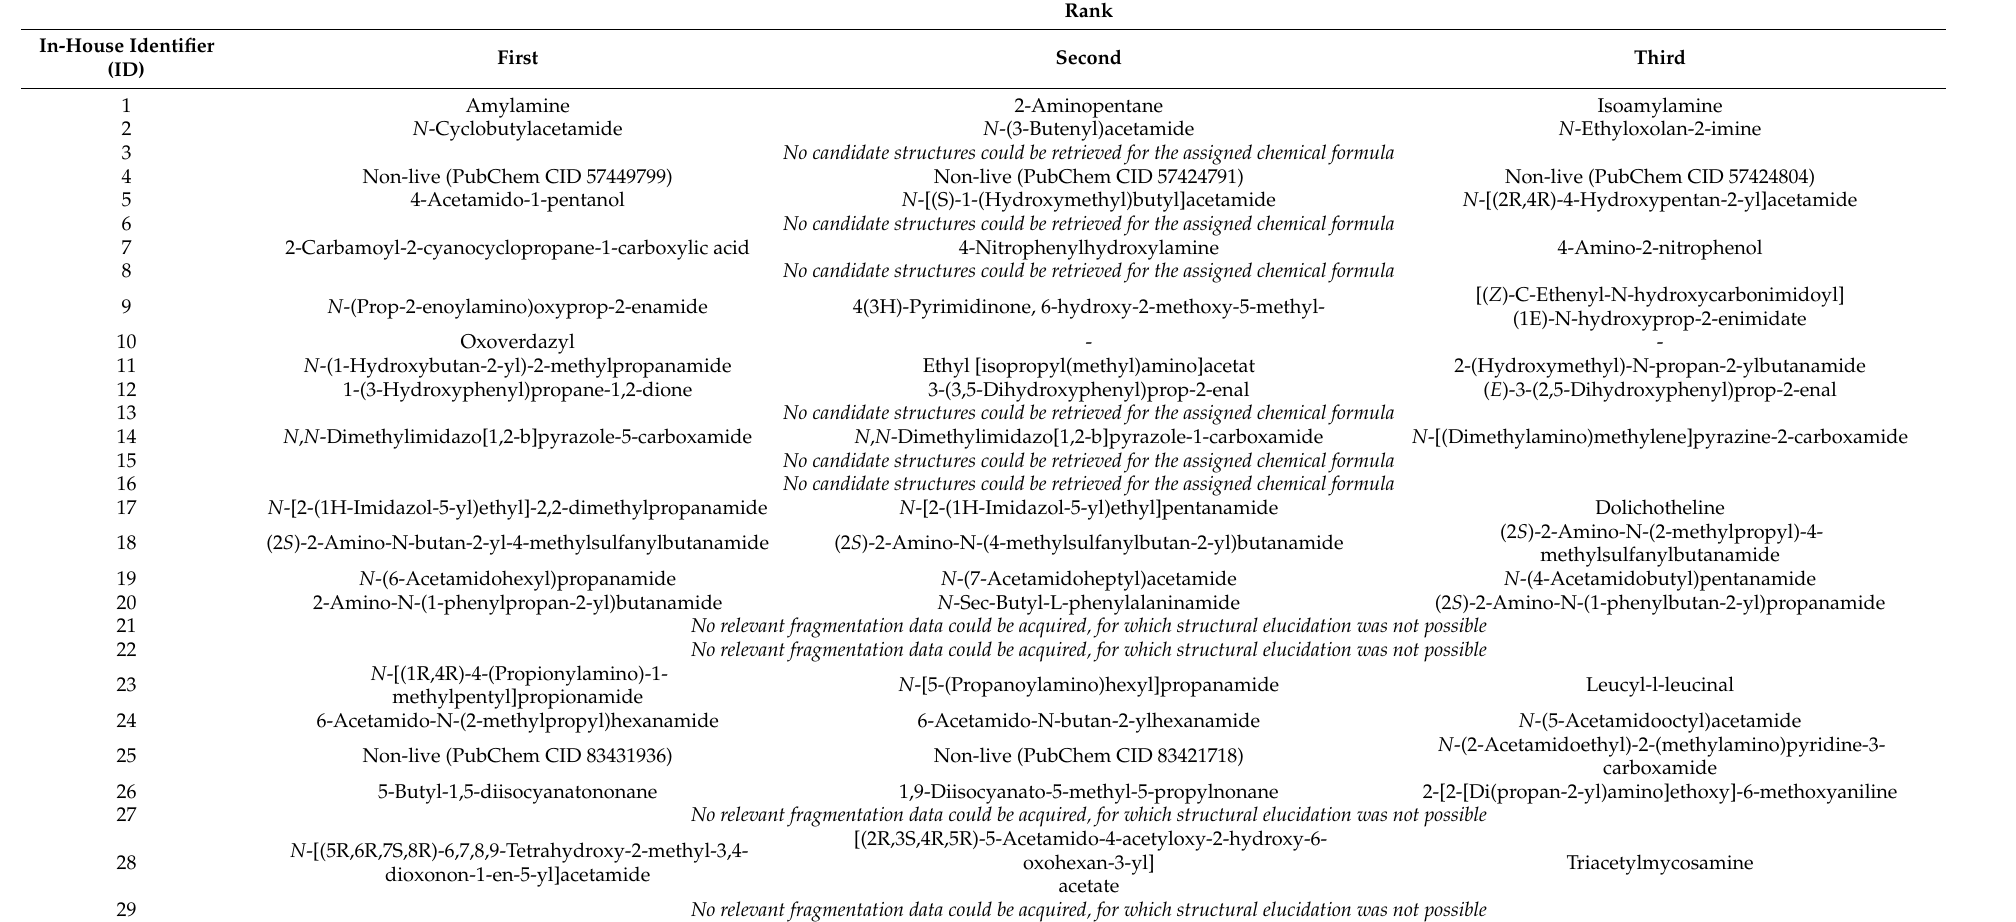
Table 2. Chemical identities, as proposed by SIRIUS software, for the top-ranked Gram-negative bacterial endotoxin candidate markers.